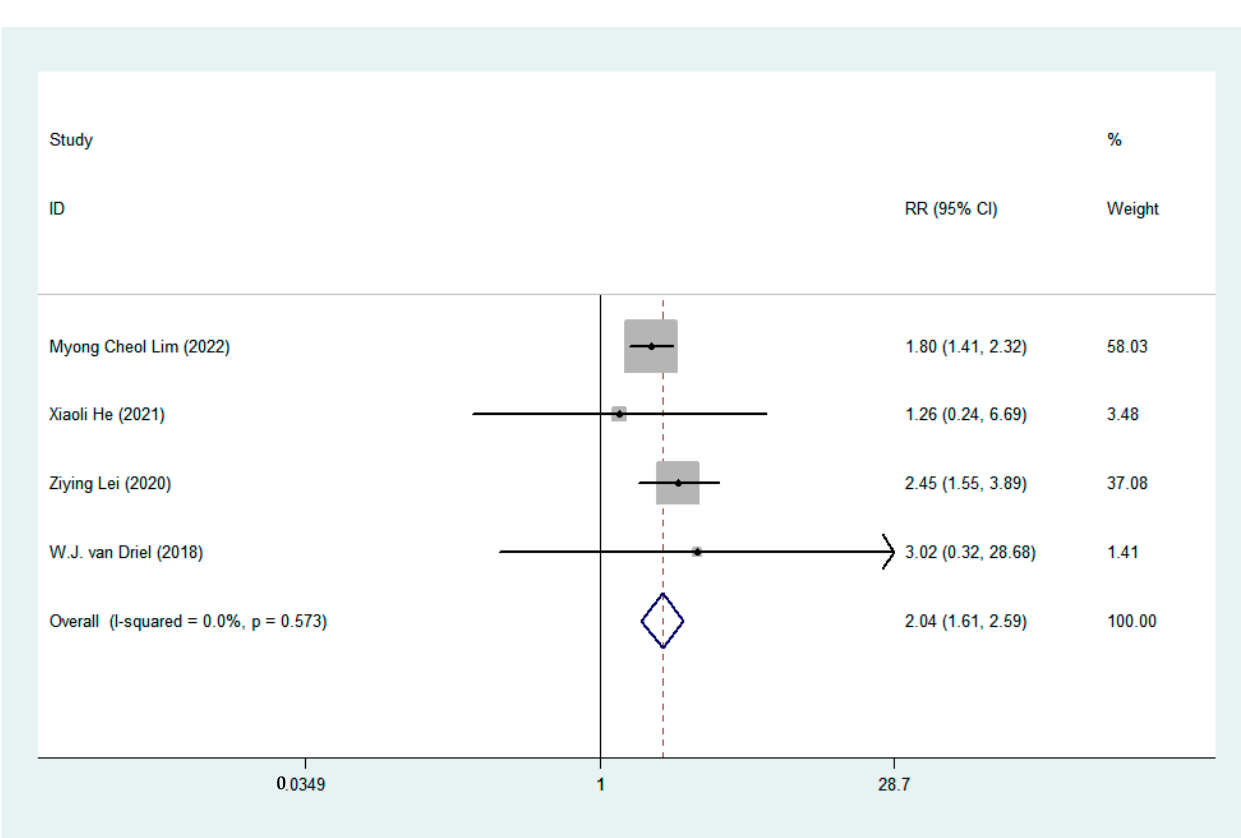
Figure 6. Forest plot of electrolyte disturbance.